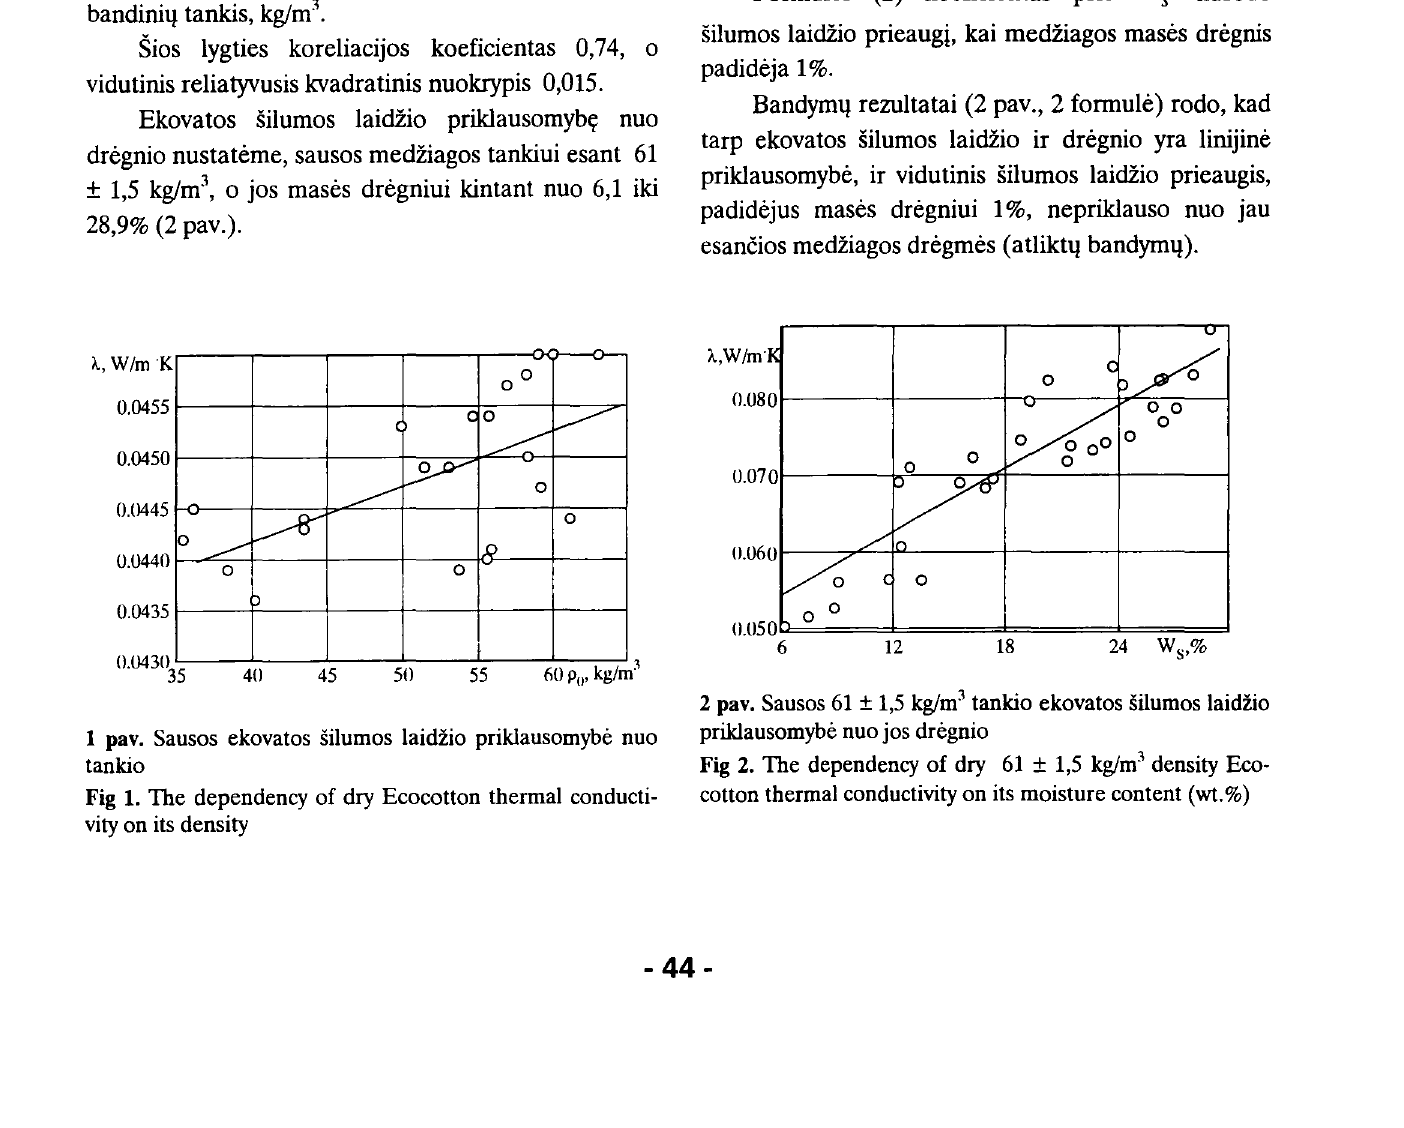
Fig 1. The dependency of dry Ecocotton thermal conducti